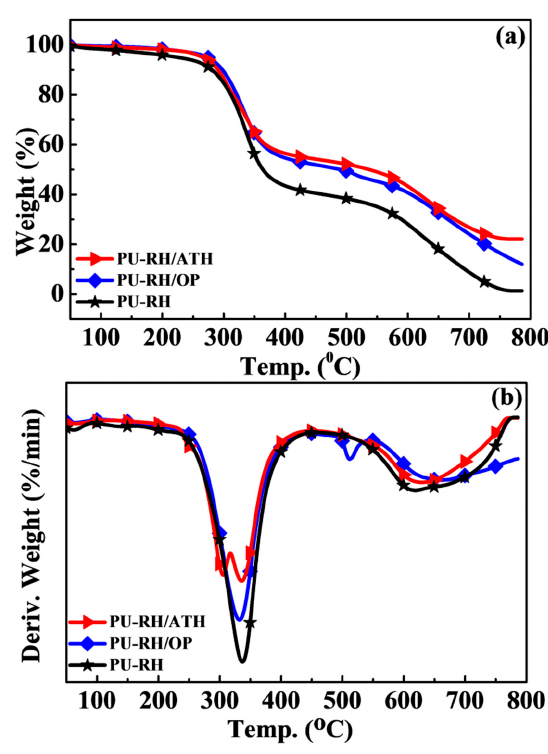
7 of 17 Table 3. Thermal stability parameters obtained by the TGA. Samples